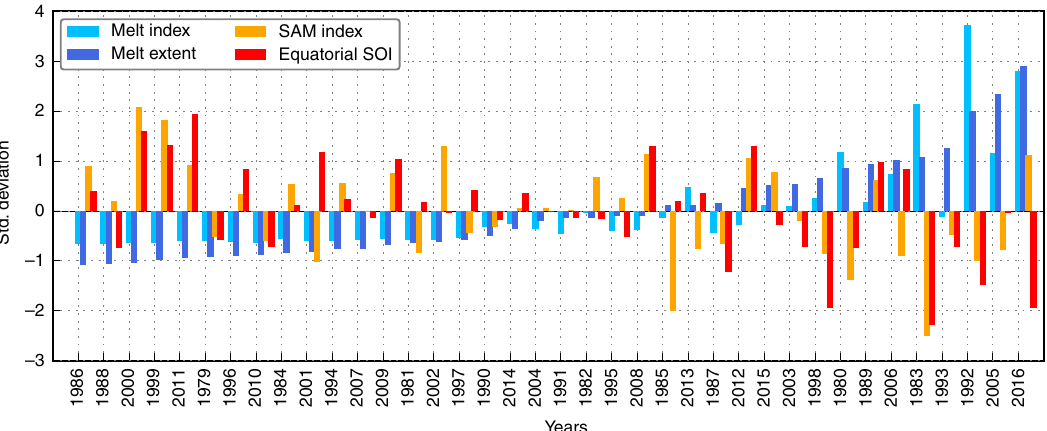
Figure 7 | 1980–2016 standardized SAM Index, Equatorial SOI, West Antarctic melt index and melt extent anomalies. Years are rank-ordered from lowest to highest melt extent. For each year ( x axis), the plot displays (in the following order) the melt index (light blue), the melt extent (dark blue), the SAM Index (orange), and the equatorial SOI (red). The plot is adapted from ref. 22.